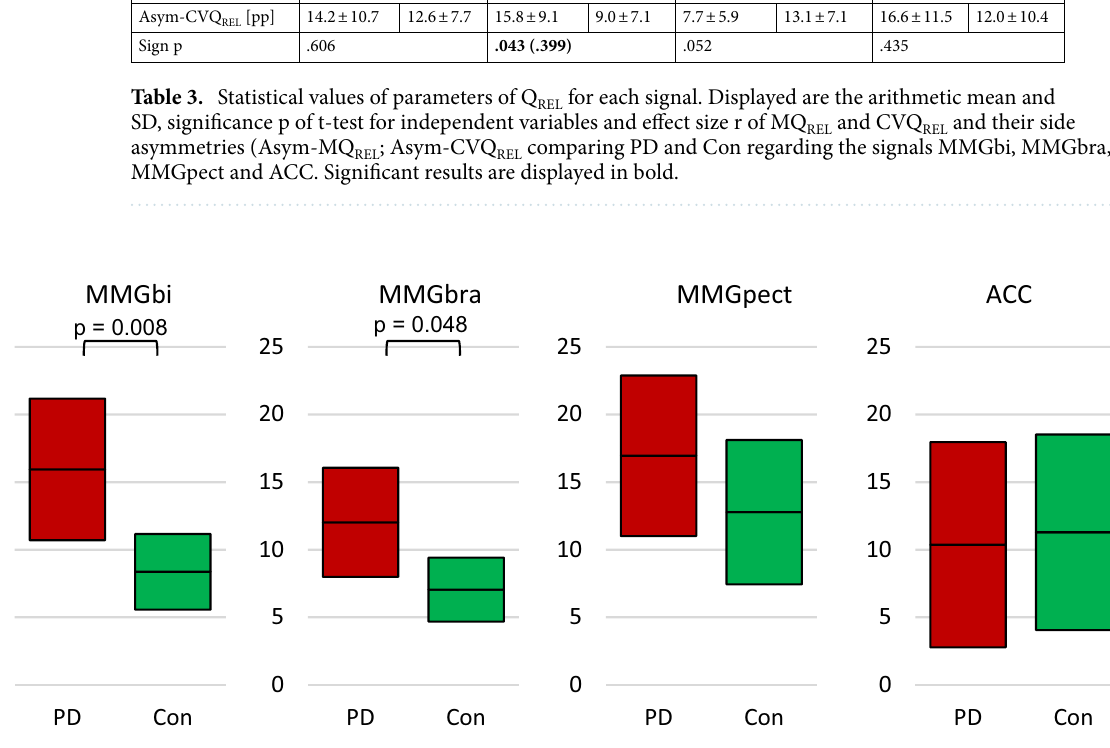
Figure 4. Interlimb asymmetries of ratio MQ REL . Displayed are the 95% confidence intervals of the side differences of the arithmetic mean of the specific ratio Q rel (Asym-MQ REL ) of the MMGs and the ACC signals. As can be seen in the MMG-signals of the elbow flexors, the PD have a higher side difference compared to the controls (p = 0.008; p = 0.048). In the MMGpect, a tendency of higher side asymmetry in PD is visible, whereas the ACC-signal show no difference between PD and